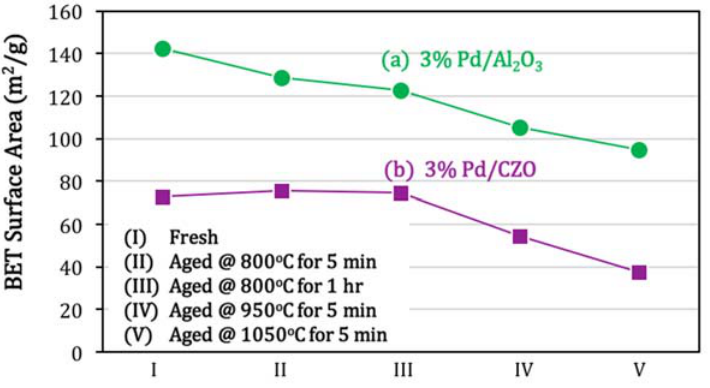
Figure 8. BET surface areas of fresh and aged ( a ) 3% Pd/Al 2 O 3 and ( b ) 3% Pd/CZO, as a function of aging conditions. Aged samples were obtained by aging the (I) fresh catalysts in air at the following conditions: (II) 800 °C for 5 min, (III) 800 °C for 1 h, (IV) 950 °C for 5 min, or (V) 1050 °C for 5 min. The aging processes were followed by cooling in air to room temperature. As a reference, BET surface areas of support materials were measured 142.9 m 2 /g and 60.3 m 2 /g respectively for fresh Al 2 O 3 and